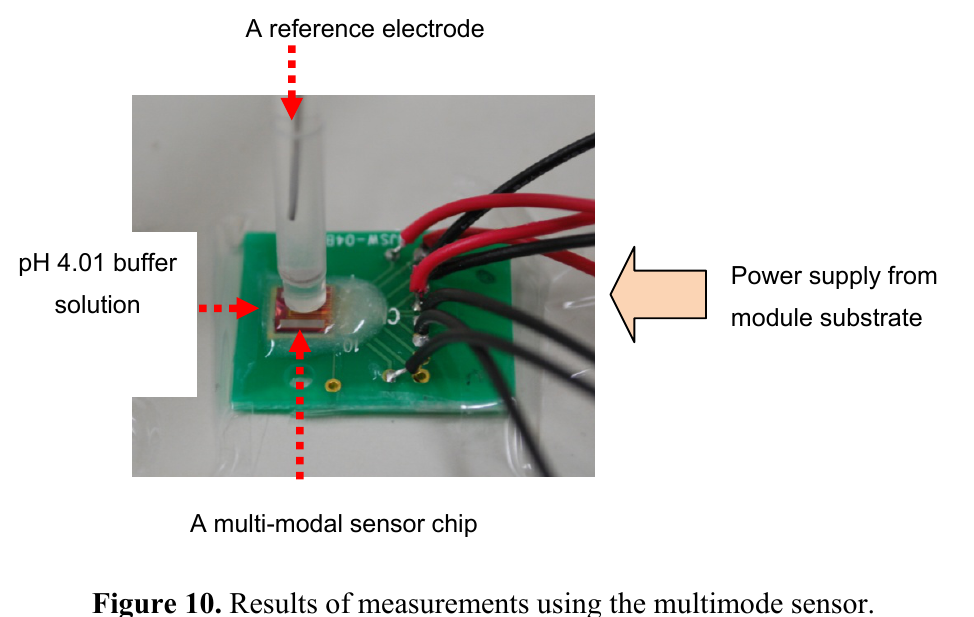
Figure 10. Results of measurements using the multimode